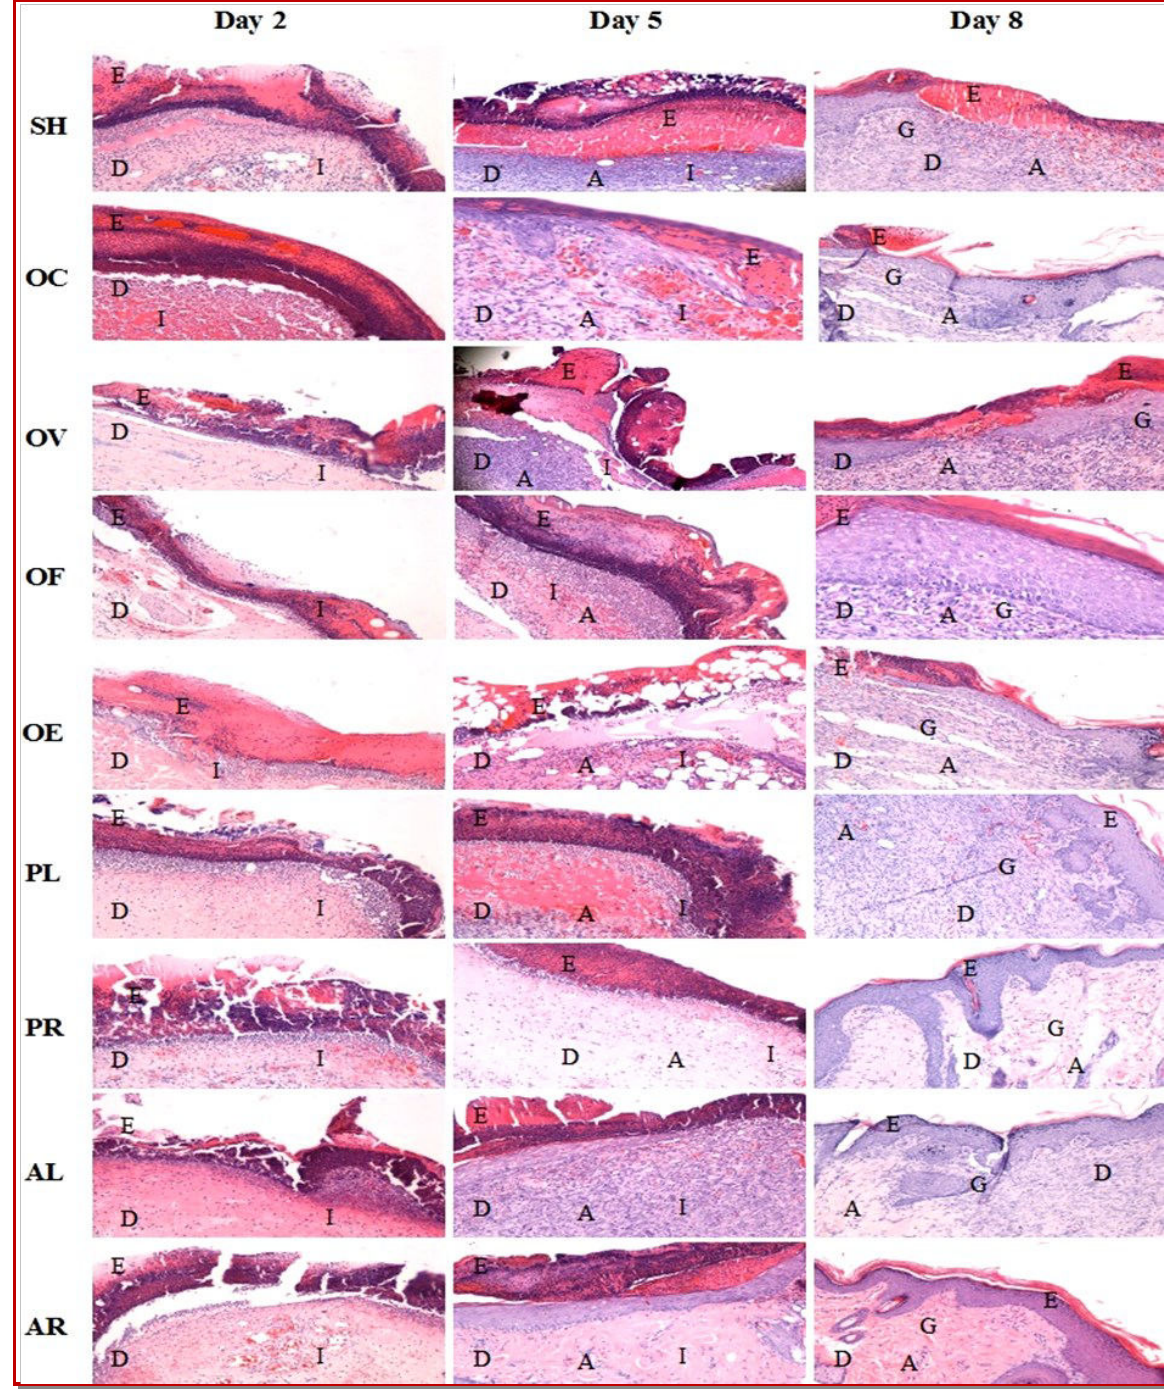
Figure 3: Histopathological view of skin wound by H & E staining of nine ovariectomized female experimental groups: SH, OC, OV, OF, OE, PL, PR, AL and AR at day 2, day 5 and day 8 after the formation of the wound. Pictures of stain are at x10 magnifica- tion. Alphabets indicate the events during wound healing; E = Epidermis, D = Dermis, I = Inflammatory cells, A = Angiogenesis, G = Granulation